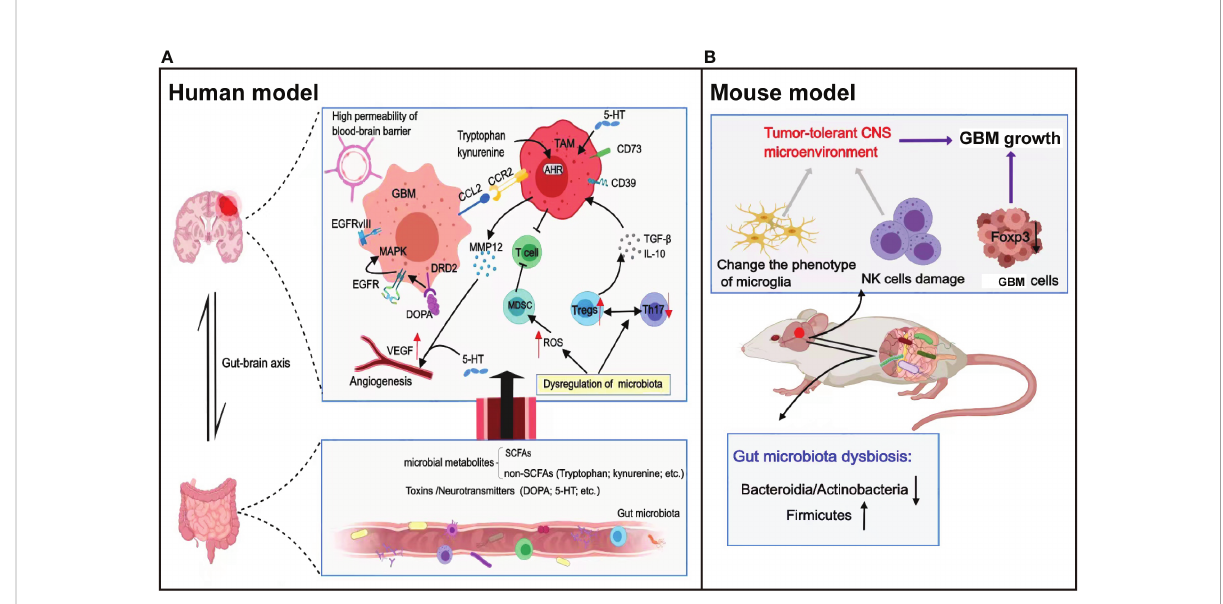
FIGURE 2 Relationship between the gut microbiota and the development of glioma. (A) The gut microbiota drives the production of metabolites and neurotransmitters, which reach the brain through blood circulation and regulate the malignant progression and angiogenesis of GBM via direct or indirect effects. In addition, dysregulation of the gut microbiota regulates the expression of ROS or the balance between immune cells to inhibit T-cell killing of tumor cells. (B) A glioma-bearing mouse model exhibited gut microbiota dysbiosis with a reduced abundance of Bacteroides and Actinobacteria, and an increased abundance of Firmicutes. In addition, gut microbiota dysbiosis leads to natural killer (NK) cell damage and alters the microglial phenotype, together mediating the tumor tolerance microenvironment in the central nervous